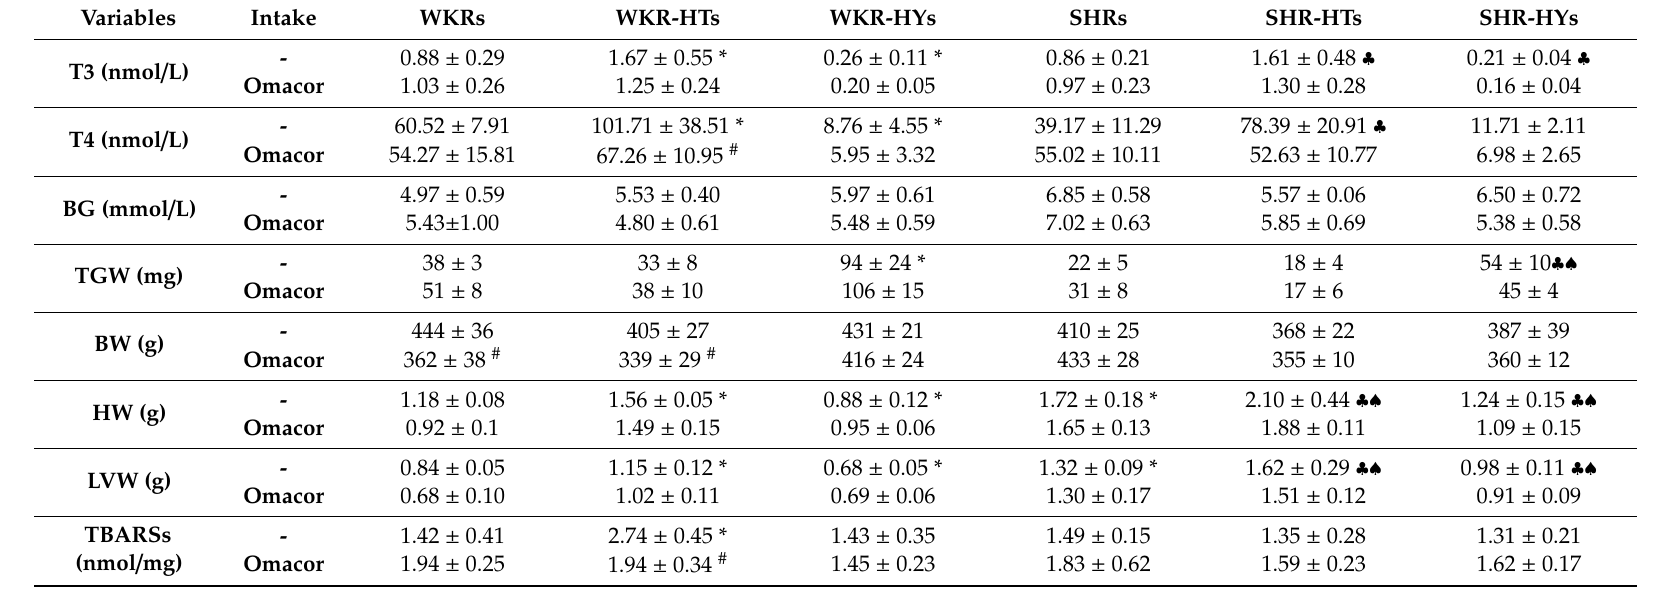
Table 1. General characteristics of experimental